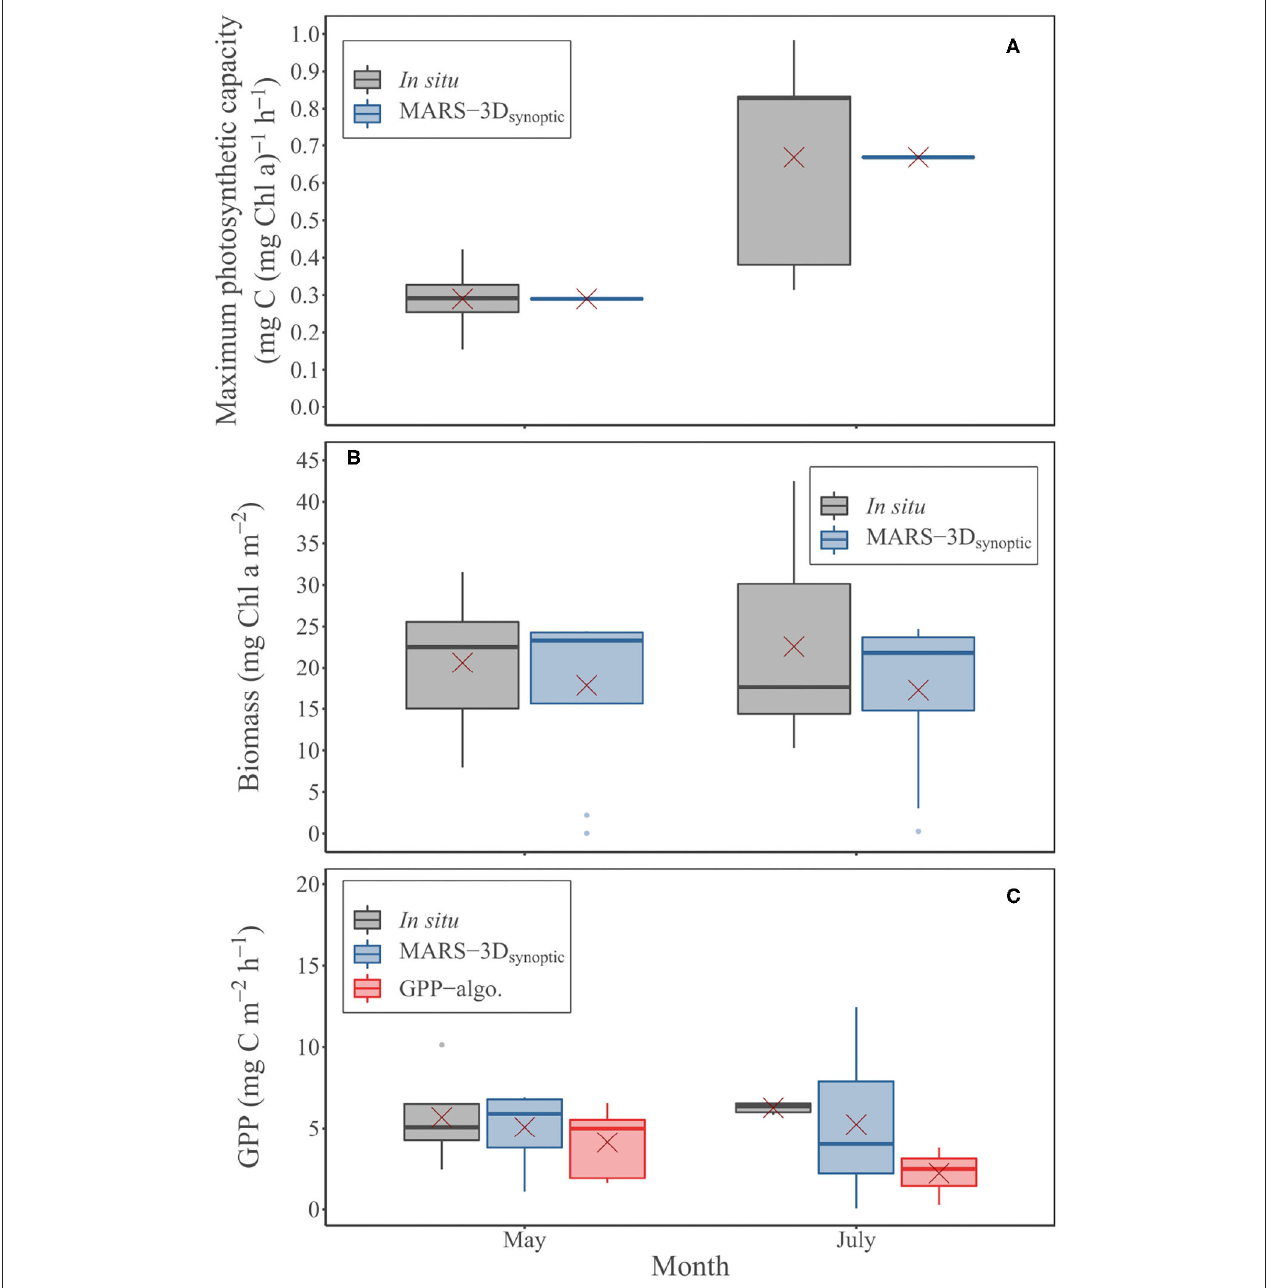
FIGURE 8 | Measured and simulated (MARS-3D synoptic run) (A) maximum photosynthetic capacity ( P b MAX , mg C (mg Chl a ) − 1 h − 1 ) and (B) MPB biomass in the biofilm (mg Chl a m − 2 ) during in situ sampling days in May and July 2015. (C) MPB GPP (mg C m − 2 h − 1 ) measured and predicted by the MARS-3D synoptic run and GPP-algo during in situ sampling days in May and July 2015. Red crosses correspond the mean value of PAR and MST for the corresponding period.